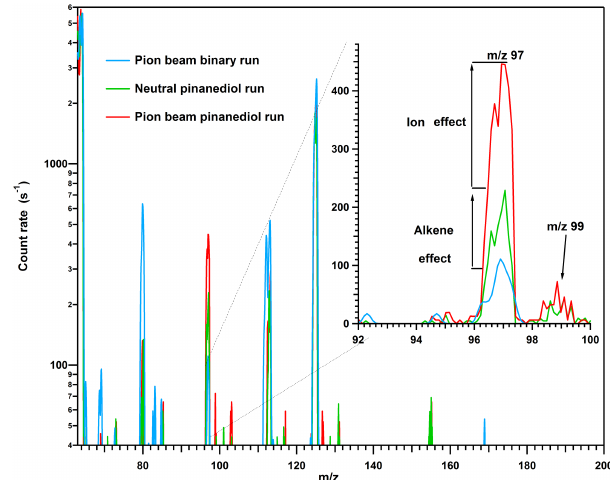
Figure 5. CIMS negative mass spectrum for a binary H 2 SO 4 –H 2 O (blue) and a pinanediol (red) experimental run in the presence of ions. For the pinanediol experimental run, the HSO − hanced by a factor of 2.25 in comparison to the equivalent neutral run